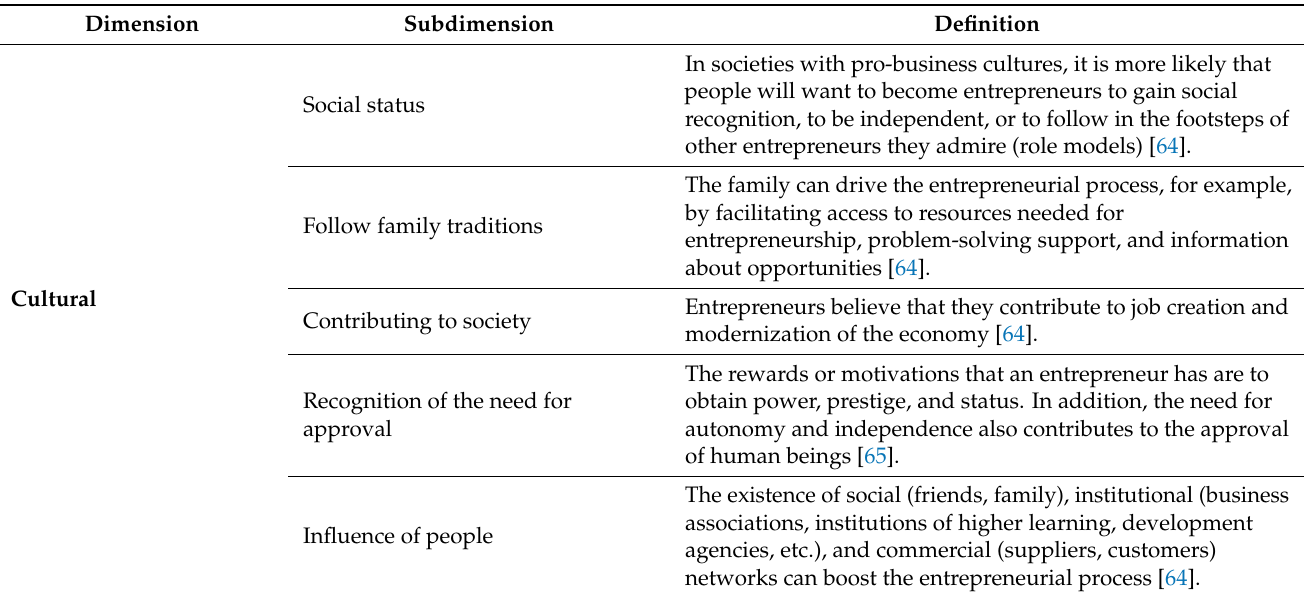
Table 2. The cultural dimension.